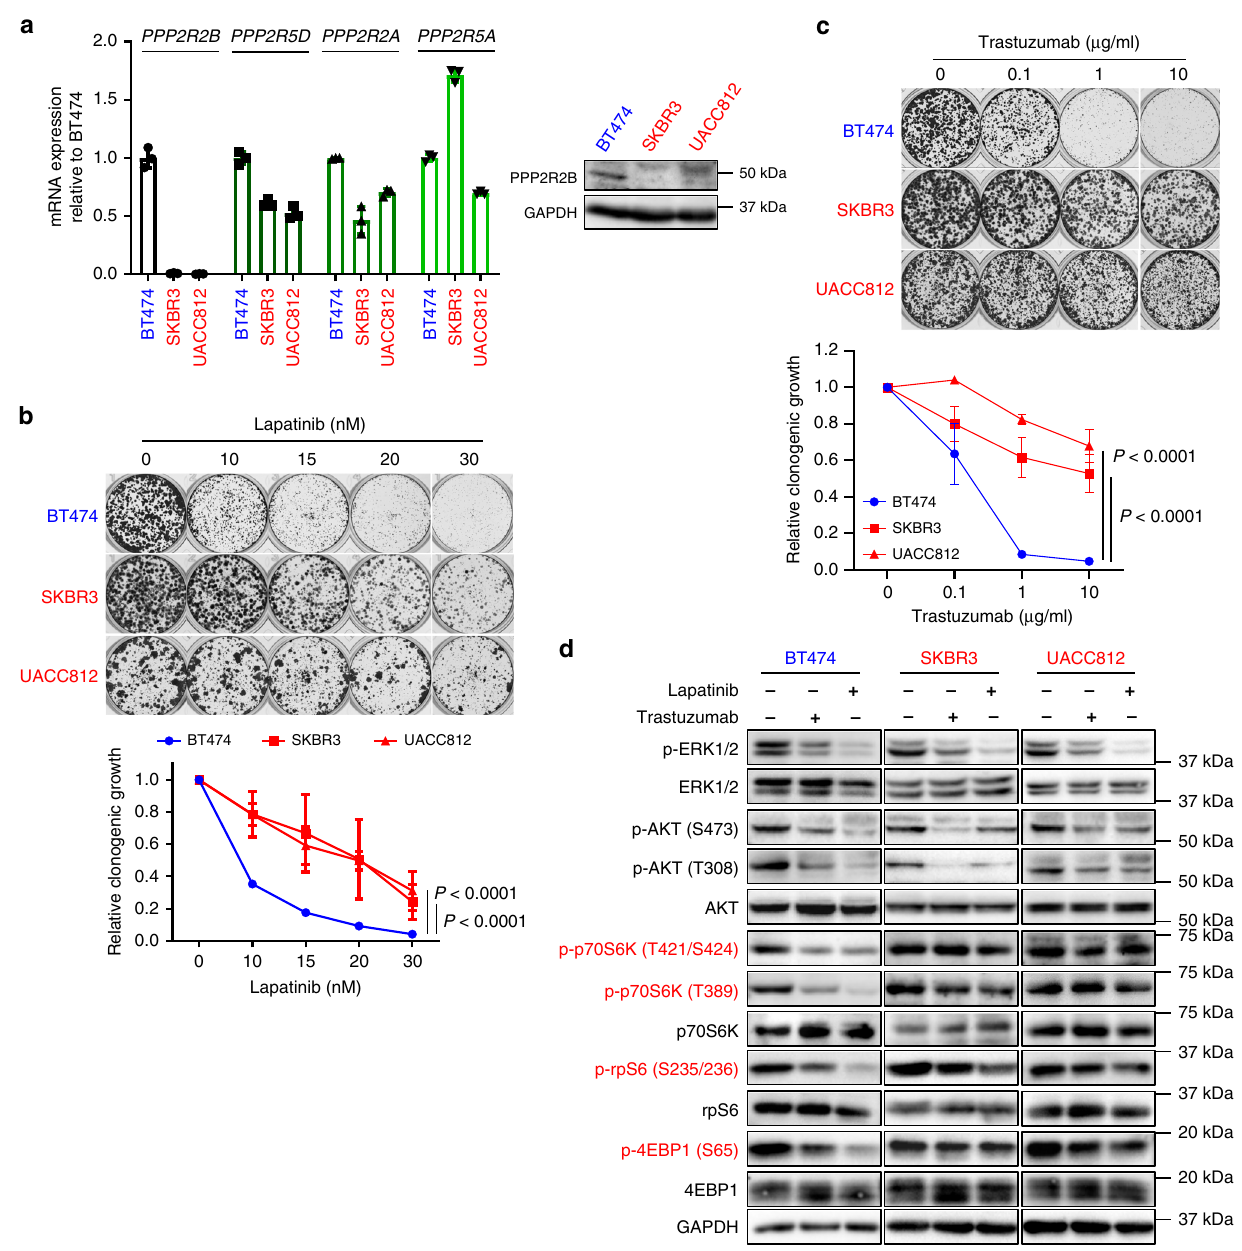
Fig. 2 Downregulation of PPP2R2B in intrinsic resistance to HER2-targeted therapies in cellular models. a Representative RT-qPCR (left; n = 2) and western blot (right; n = 2) assessing the expression of the indicated PP2A members in the indicated cell lines. RT-qPCR data are expressed as mean ± s.d. of technical triplicates. b Representative images (top) and quanti fi cation (bottom) of clonogenic assay for the responses of the indicated cell lines to lapatinib. c Representative images (top) and quanti fi cation (bottom) of clonogenic assay for the responses of the indicated cell lines to trastuzumab. Data in b and c are expressed as means ± s.d. of three independent experiments. P values in b and c were determined by two-way ANOVA. d Representative western blot analysis ( n = 2) of signaling pathways downstream of HER2 with the indicated cell lines treated with or without 10 µ g/ml trastuzumab or 40 nM lapatinib. Effectors downstream of mTOR were highlighted in red. The cell line sensitive to HER2 inhibition (BT474) is labeled in blue, whereas the ones resistant (SKBR3 and UACC812) are in